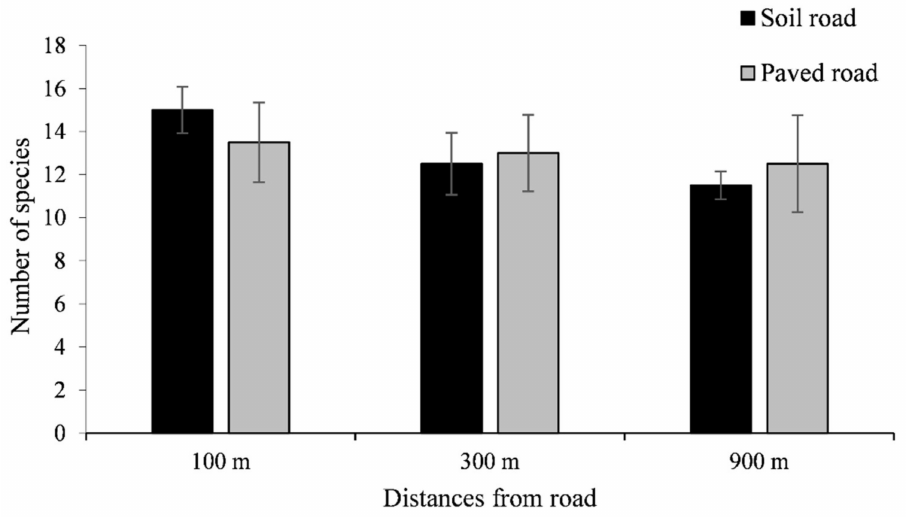
Figure 5. Plant species richness at three distances from the paved and soil roads. Each bar represents mean ± 1 SE.